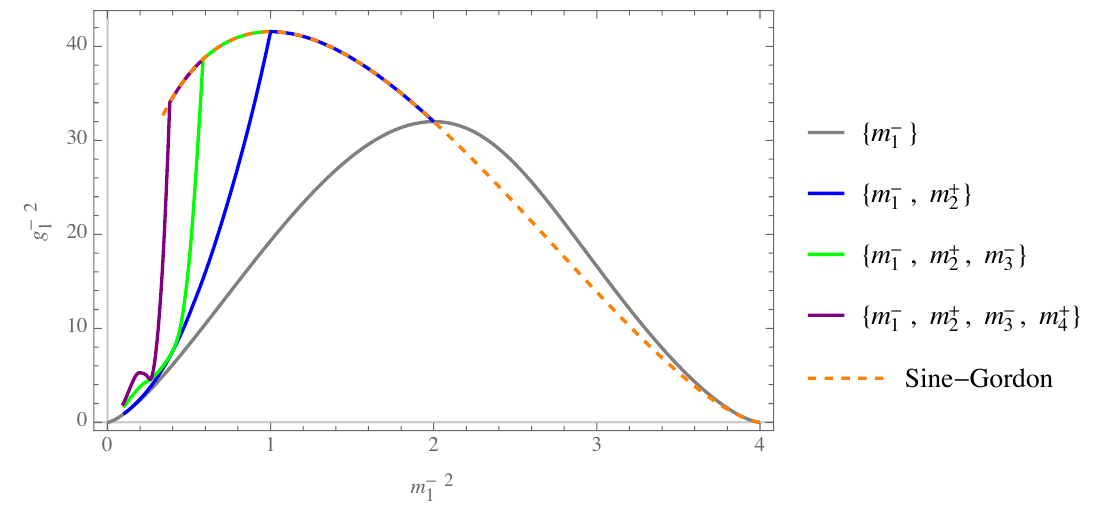
Figure 2 . Bound of a coupling to lightest pseudoscalar particle in the presence of other scalar or pseudoscalar states, and comparison with the sine-Gordon model, which saturates the bound as soon as two particles are present. Further explanations in the main text. The x-axis is the pole of the lightest bound state, and the y-axis is the corresponding residue bounds. We (cid:12)nd there are is a sharp turn at the point when new bound states are created in the Sine-Gordon